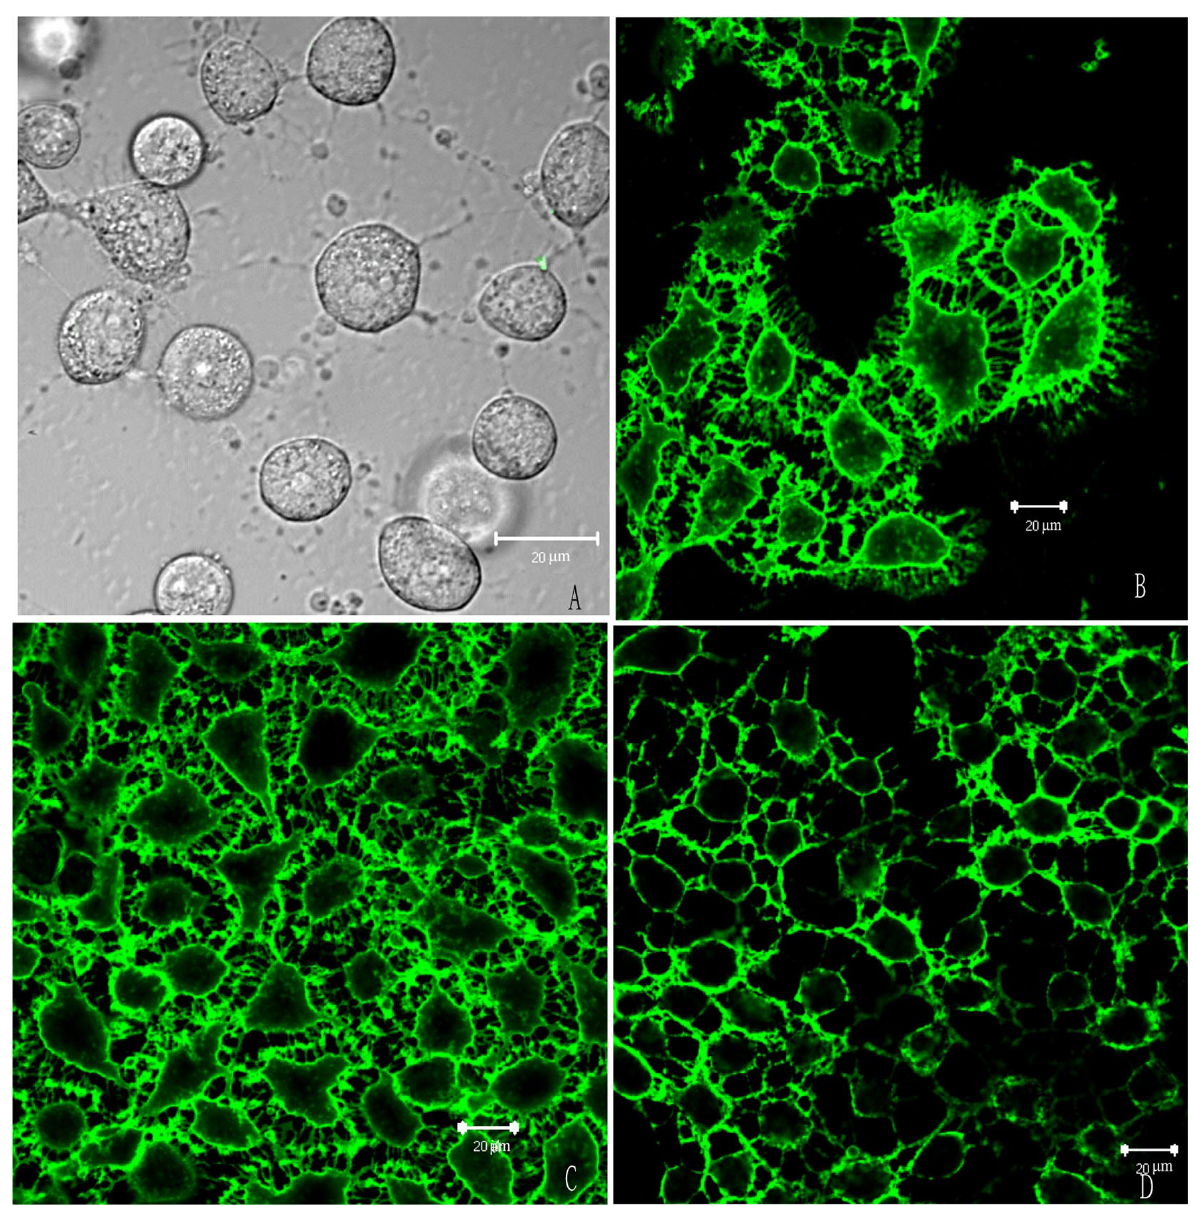
Figure 5. Confocal laser microscopy image of immune sera binding with the membrane of proliferating HUVECs. Immune sera from HUVECs (B), HUVECs+CRM197 (C), and CRM197 (D), but not sera from the PBS group (A), were able to bind to the membrane of HUVECs. HUVECs = human umbilical vein endothelial cells; CRM197 = nontoxic diphtheria